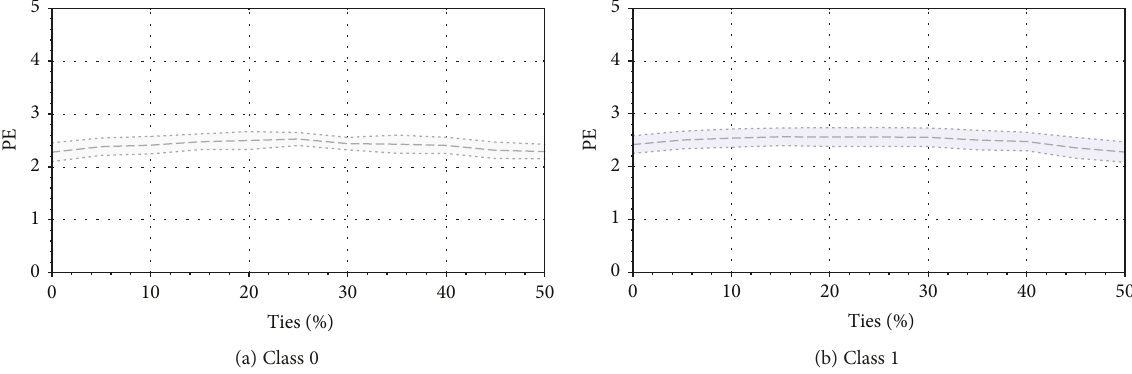
Figure 6: PE changes for variations of synthetic ties between 0% (baseline) and 50% for CGM